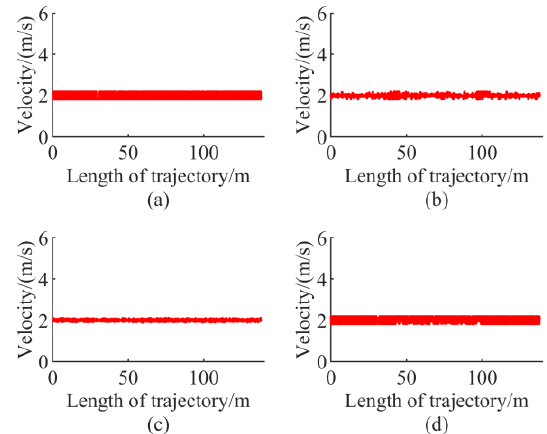
Figure 28. The velocity with the positioning error in ±0.1m. ( a ) LMPC. ( b ) LEMPC. ( c ) NMPC. ( d ) NEMPC.